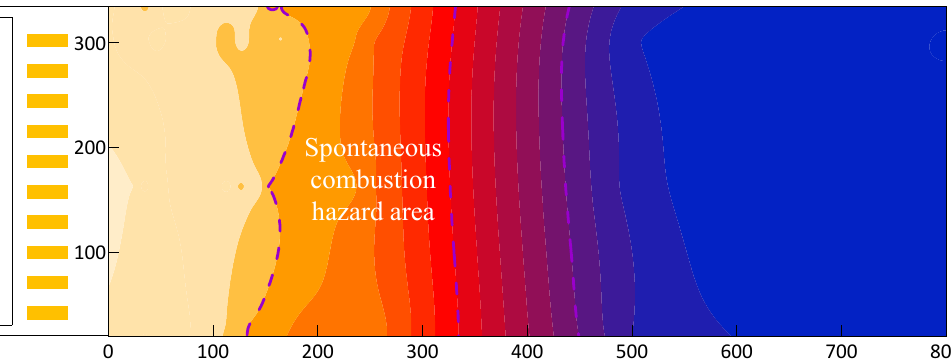
Figure 9. Distribution of coal spontaneous combustion hazardous zone in the gob (own elaboration).